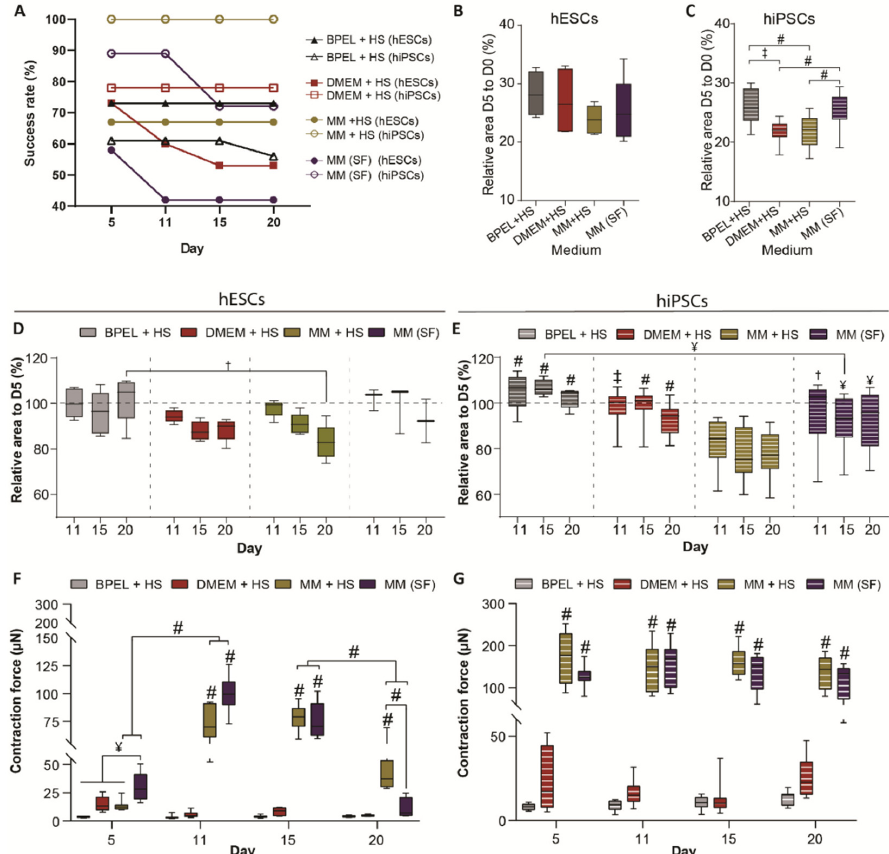
Figure 4. EHT comparison in different media with and without HS. ( A ) Success rate of tissue for- mation in hESCs and hiPSCs. ( B , C ) Early-stage compaction measured by comparing the tissue area at day 5 with the initial area at day 0 in each condition in hESCs ( B ) and hiPSCs ( C ). ( D , E ) Late-stage compaction measured by comparing the tissue area at day 11, 15, and 20 with its area at day 5 in the different media in hESCs (D) and hiPSCs ( E ). In ( E ), p-values indicate significant differences com- pared with MM+HS within the same timepoint unless otherwise indicated. ( F , G ) Contractile force of EHTs in each medium in hESCs ( F ) and hiPSCs ( G ) at day 5, 11, 15, and 20. In ( F , G ), p-values represented without significance line indicate significant differences versus BPEL+HS and DMEM+HS. HESCs data are shown as means, maxima, and minima. Two-way ANOVA plus Tukey’s test for comparisons among media and one-way ANOVA plus Tukey’s test for comparisons within one medium: ¥ = p <0.05; † = p <0.01; ‡ = p <0.001; and # = p <0.0001 ( N = 4, biological replicates from independent differentiations). HS, horse serum and SF, serum free.